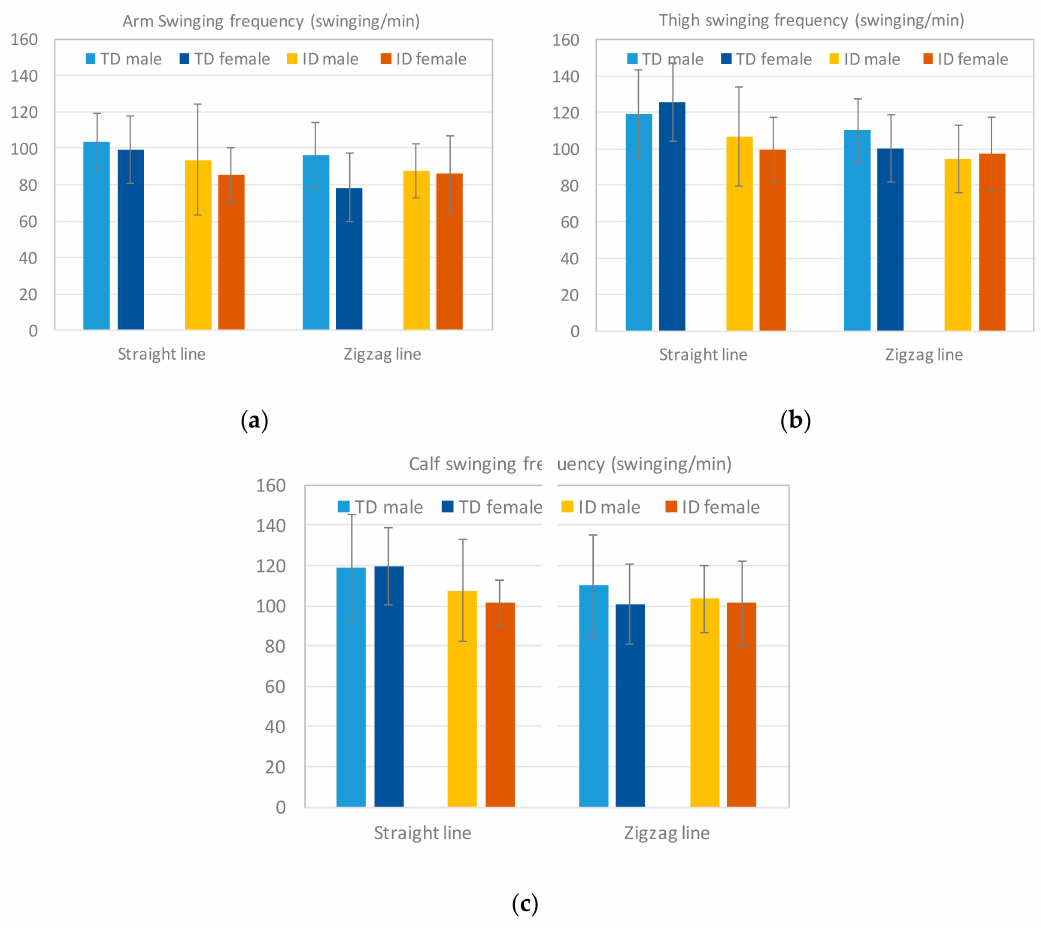
Figure 14. Results of the limb swinging frequency: ( a ) F swing _ arm , ( b ) F swing _ thigh , and ( c ) F swing _ calf . The participants with ID displayed overall lower limb swing frequencies in both